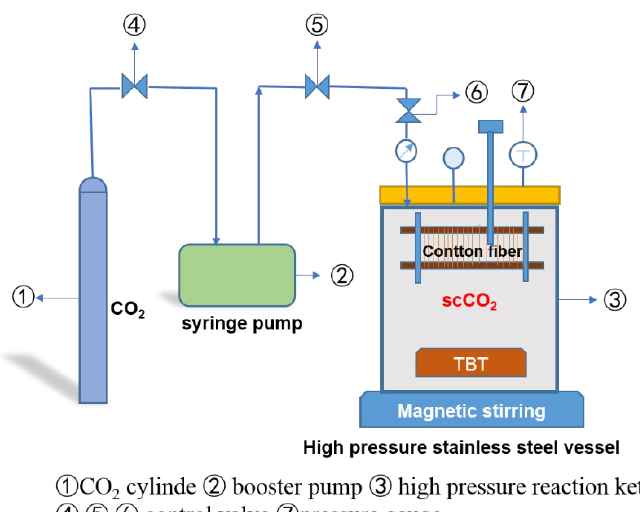
Figure 1. The scheme of theSCCO 2 treatment device.